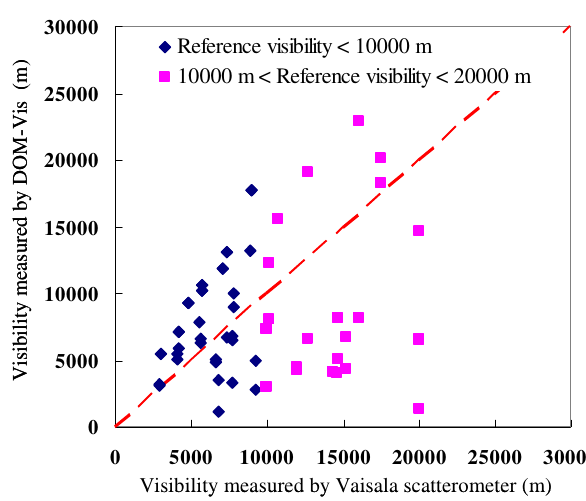
Fig. 5. Comparison of Vaisala scatterometer measurements to Figure 5. Comparison of Vaisala scatterometer measurements to DOM-Vis results when 489 DOM-Vis results when the reference visibility was < 10km (blue the reference visibility < 10 km (blue diamonds), and 10 km < the reference visibility < 490 diamonds), and 10km < the reference visibility < 20km (pink 20 km (pink squares) during nighttime tests. 491 squares) during nighttime